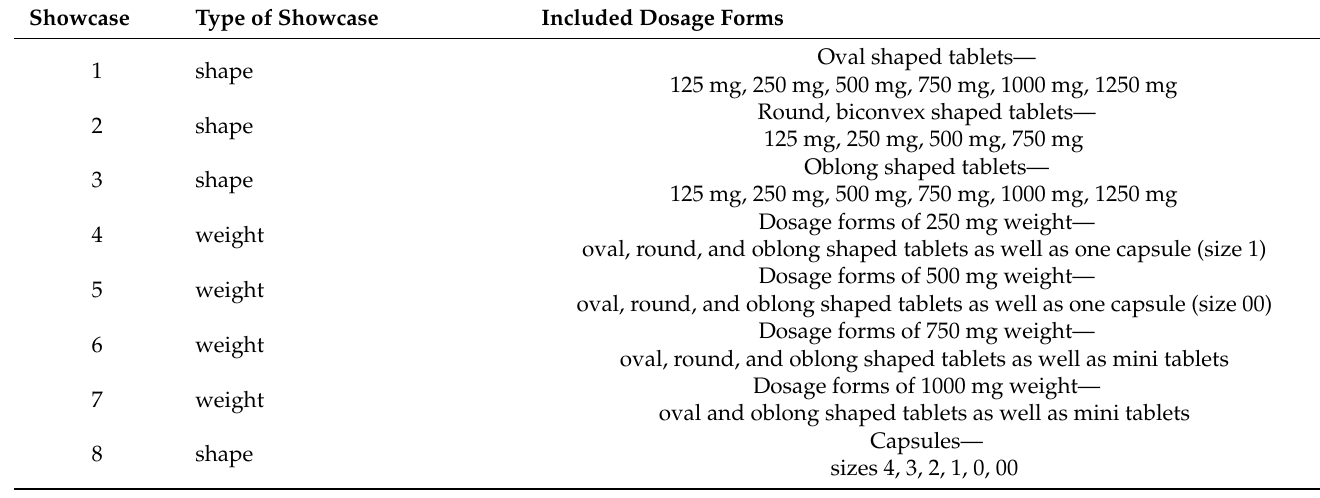
Table 3. Composition of the eight showcases representing different